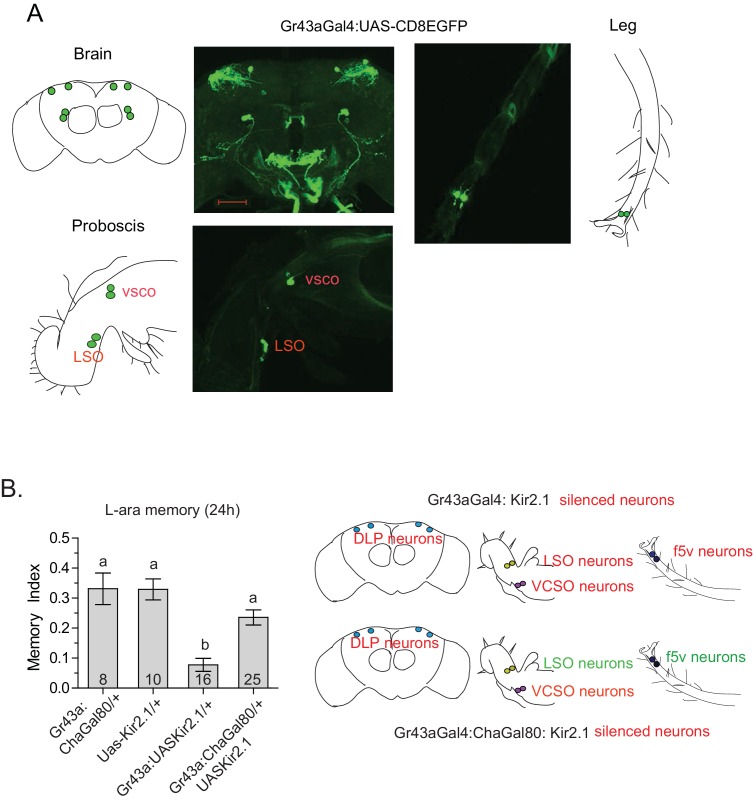
Tarsal Gr43a neurons are critical for L-arabinose memory.(A) Gr43aGAL4 neurons are observed in the dorsolateral protocerebrum, central brain, proboscis, leg, and gut (not shown). (B) Silencing only the dorsal protocerebral (DLP) and VCSO neurons does not impair L-arabinose memory. Left panel: memory score in various genetic backgrounds. Right panel, top: in Gr43aGAL4/+; Kir2.1/+ flies, all indicated neurons are silenced (including proventricular neurons, not pictured). Bottom: in Gr43aGAL4:ChaGal80/+; UAS-Kir2.1/+ flies, only the neurons indicated in red type are silenced. For multiple samples, one-way ANOVA with Tukey’s multiple comparisons test was performed, and significant differences (p<0.05) are denoted by different letters. Results with error bars are means ± s.e.m. ns, not significant. *≤0.01, **≤0.001 and ***≤0.0001.